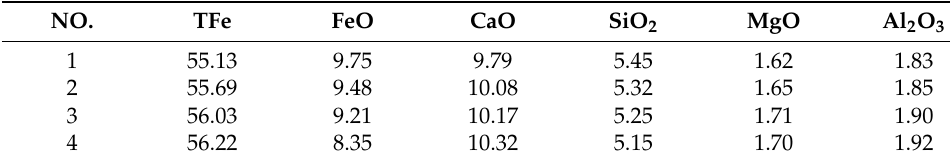
Table 4. Sinter’s chemical composition (mass fraction, %).